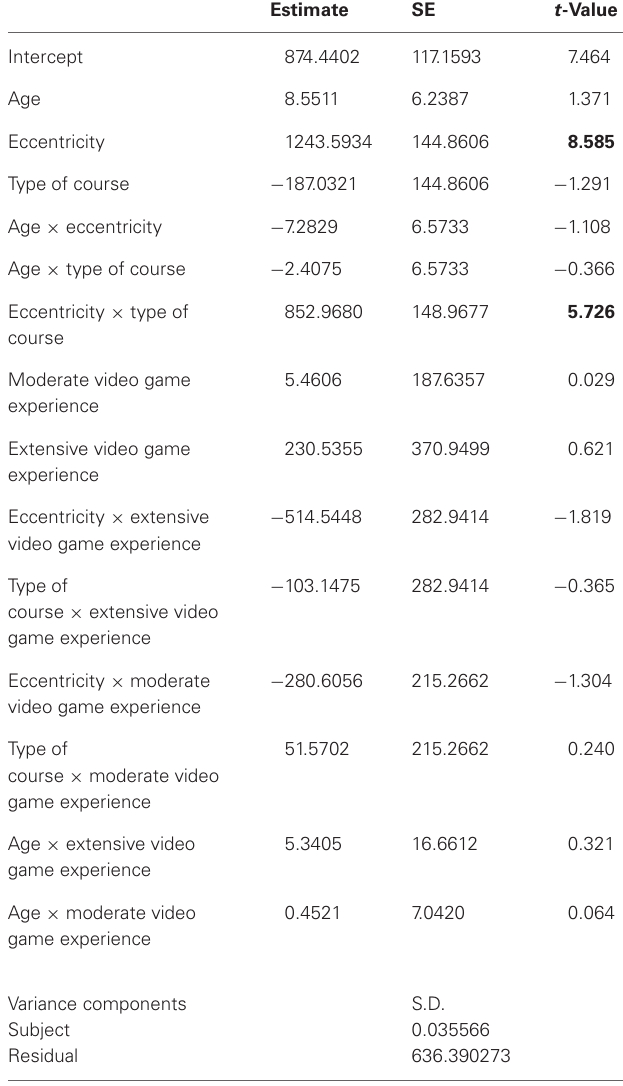
Table 4 | Linear mixed model for first detection or fixation of objects (significant effects with t -value ± 2 in